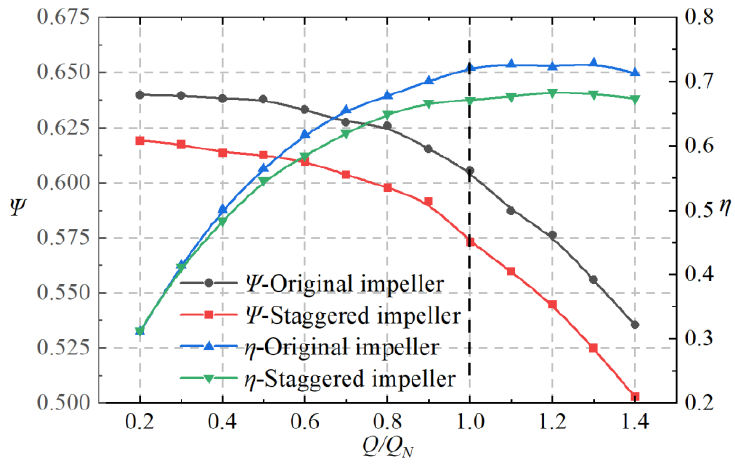
Figure 4. Performances of the model pump. Table 2. Drop range of head coefficient and efficiency of the staggered impeller model pump.